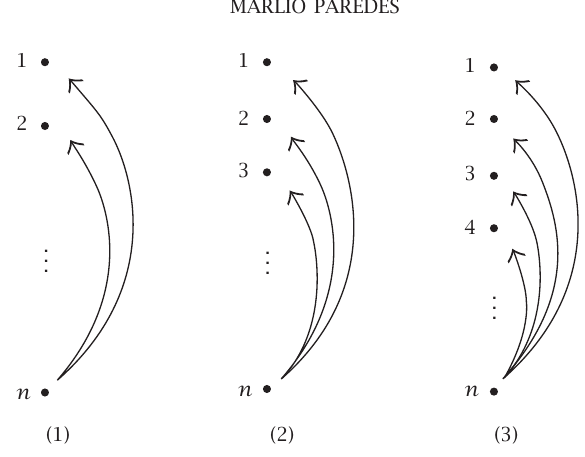
Figure 4.2 Tournaments in Propositions 4.2, 4.3, and